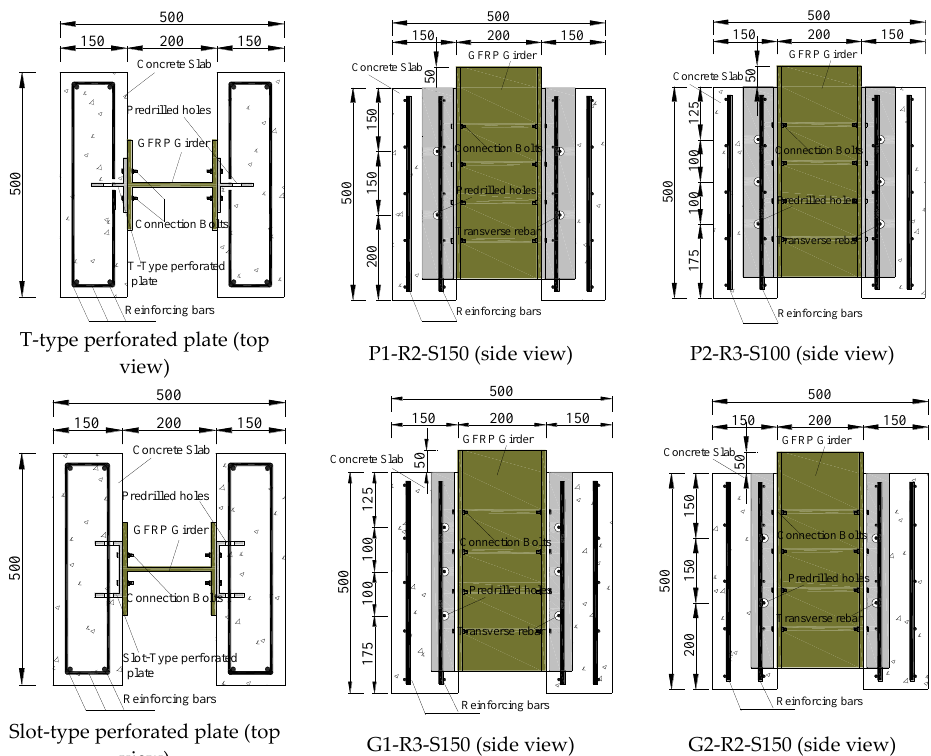
Figure 1. Composition of the push-out specimens (units: mm).